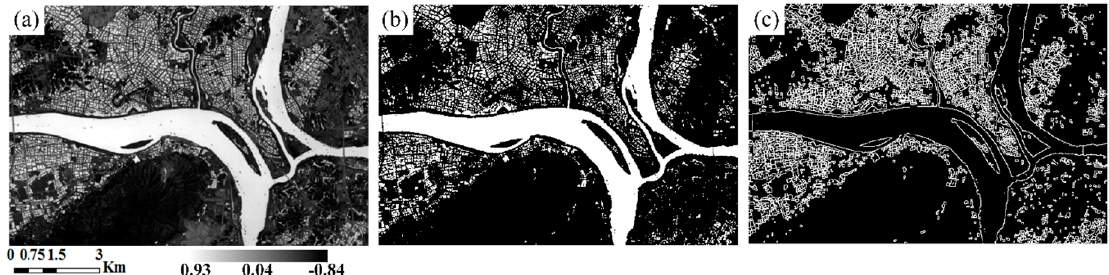
Figure 3. Pure water and mixed water-land pixels for Region A: ( a ) normalized difference water index (NDWI) image of green and SWIR1 bands; ( b ) pure water pixels (white) of NDWI with a 0.093 threshold; and ( c ) mixed water-land pixels (white).